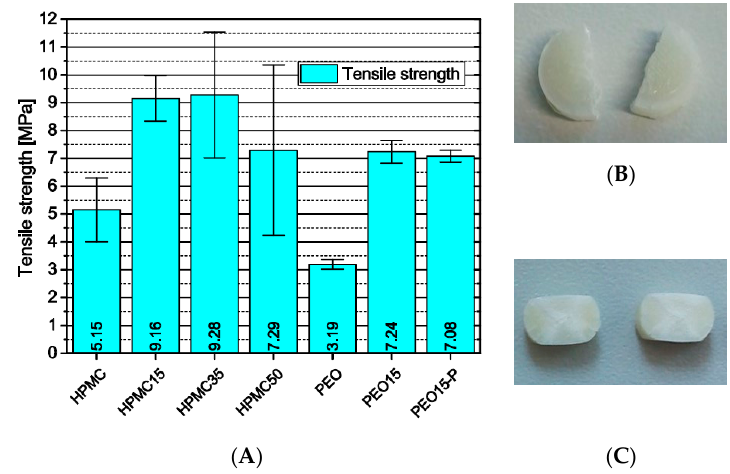
Figure 10. ( A ) Tensile strength of 3D-printed cylinders via Brazilian test, n = 6; ( B ) PEO cylinders after test; ( C ) PEO15 cylinders after test.